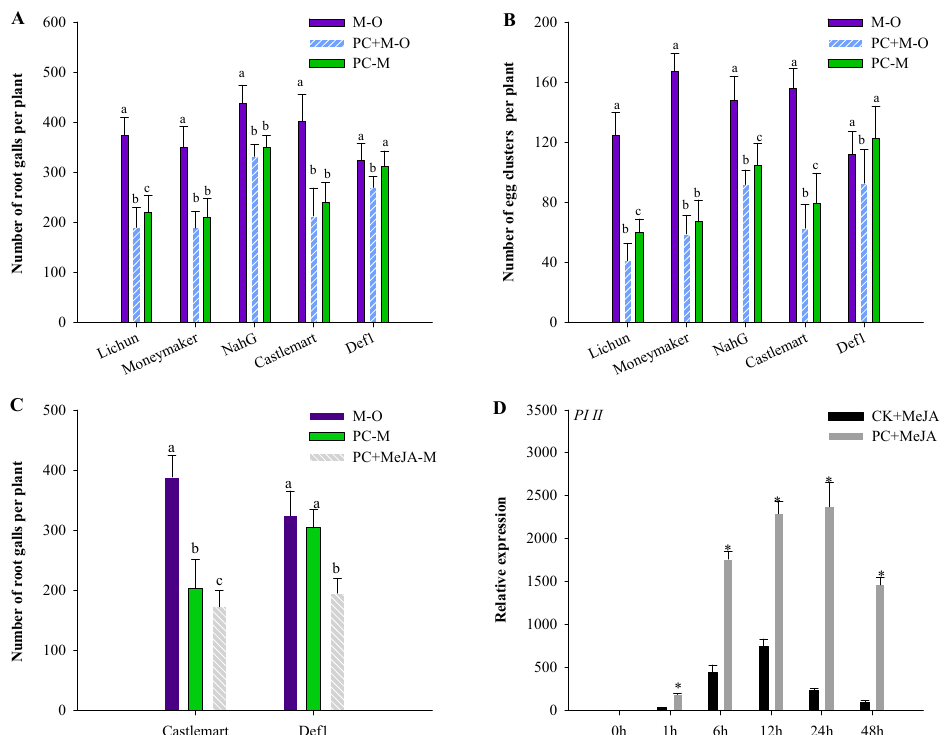
Figure 8. Pochonia chlamydosporia -induced resistance against Meloidogyne incognita in different tomato lines ( A ) The number of root galls was monitored at 45 d after inoculation with M. incognita . ( B ) The number of egg clusters in the roots was monitored at 45 d after inoculation with M. incognita . Data are the mean ± SE ( n = 30). ( C ) The number of galls was monitored at 45 d after exogenous application of methyl jasmonate (MeJA). Data are the mean ± SE ( n = 30). Each value is the mean ± SE of three biological samples. Different letters indicate statistical differences between treatments ( p < 0.05). Each value is the mean ± SE ( n = 30). ( D ) PI II was analyzed at six time points after exogenous application of methyl jasmonate (MeJA). Each value is the mean ± SE of three biological samples with three technical replicates each. * indicate a significant difference from non-PC-170-inoculated plants according to Dunnett’s test ( p < 0.05; n = 5).